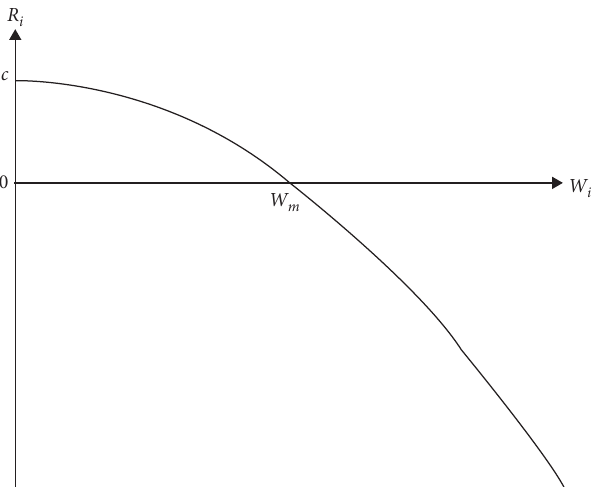
Figure 7: Schematic diagram of the function of reward as a function of waiting